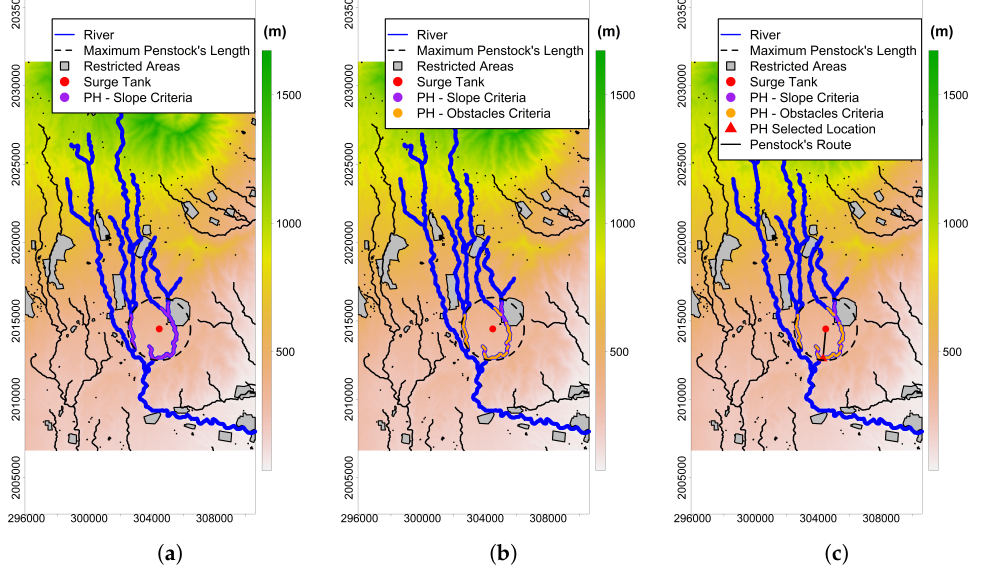
Figure 3. Powerhouse site selection process. ( a ) Slope Criteria ( b ) Obstacles Criteria ( c ) Maximum gross head. Maximum permissible penstock’s length for example is set to R PH = 2000